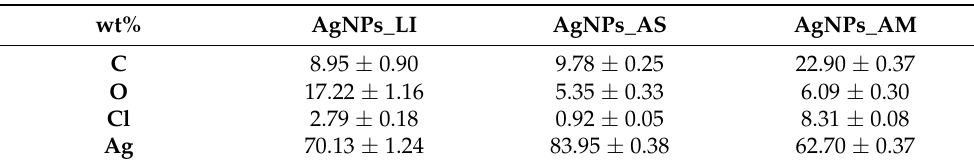
Table 1. Energy-dispersive X-ray spectroscopy (EDX) analysis of AgNPs from L. indica (LI), A. scholaris (AS), A. multifolium (AM). All measurements were performed in no less than five replicates.